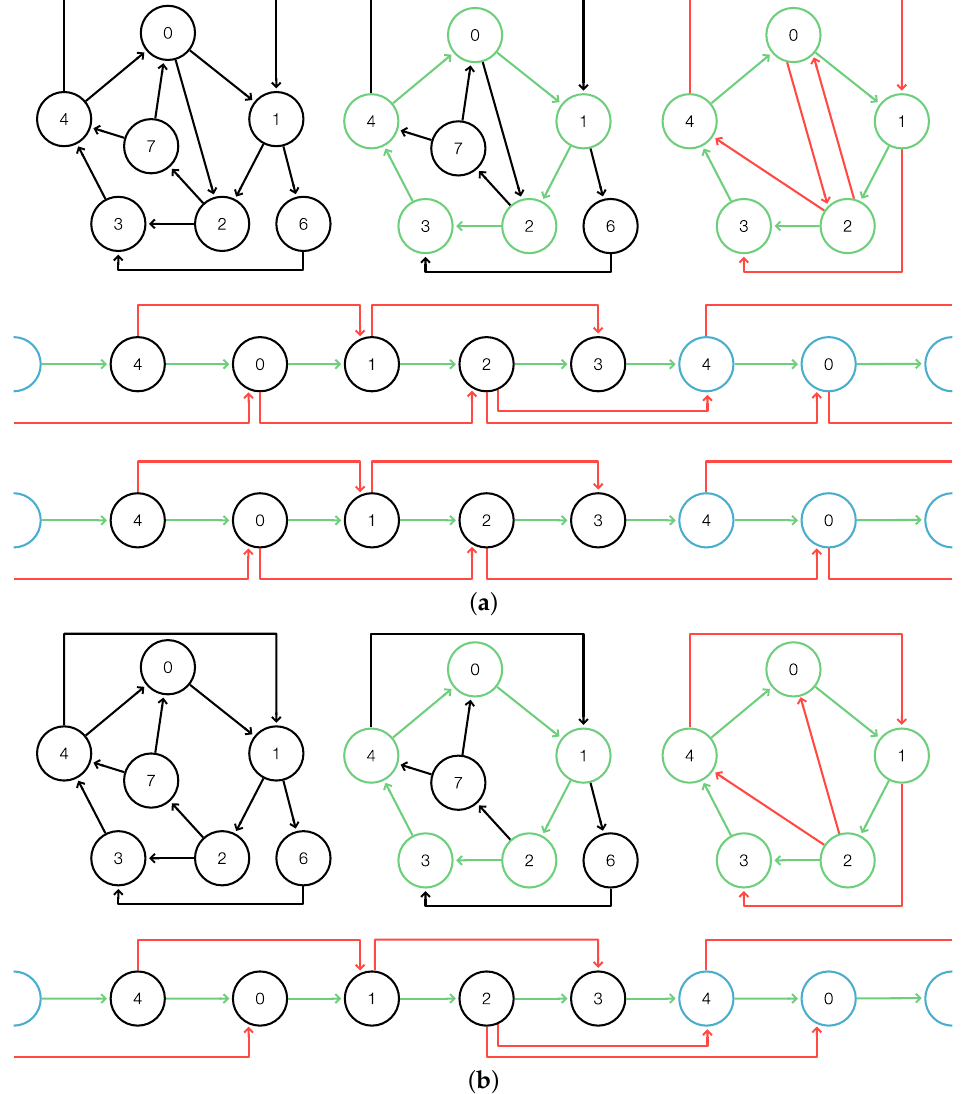
Figure 3. C (cid:32) -covers. ( a ) The green cycle C in the top panel has five C (cid:32) -paths indicated in red. In the middle panel, C is laid out linearly to emphasize the C (cid:32) -covered intervals. Below, the clean C (cid:32) -cover obtained by removing all C (cid:32) -intervals that are contained in longer ones. Note that every C (cid:32) -interval is extended by another one; hence, the C (cid:32) -cover is total. ( b ) Again, the top panel highlights C in green and the C (cid:32) -paths in red. The linear layout below highlights that Vertex 1 is not C (cid:32) -covered. Thus, it is a C (cid:32) -cut